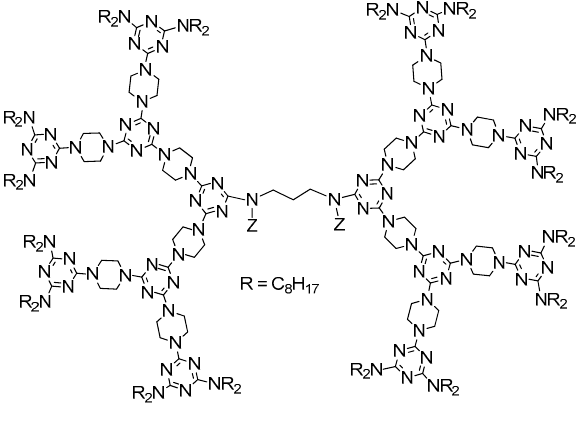
Figure 10. Structures of dendrimers ( 15 ) and ( 16